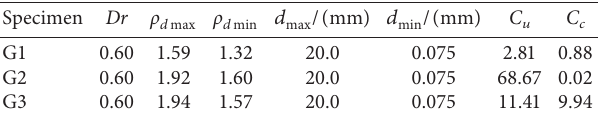
Figure 6: Particle size distributions of the gap-graded rock-soil mixtures G1, G2, and G3 for the direct shear and triaxial tests. Table 1: Physical properties of gap-graded rock-soil mixtures G1, G2, and G3.